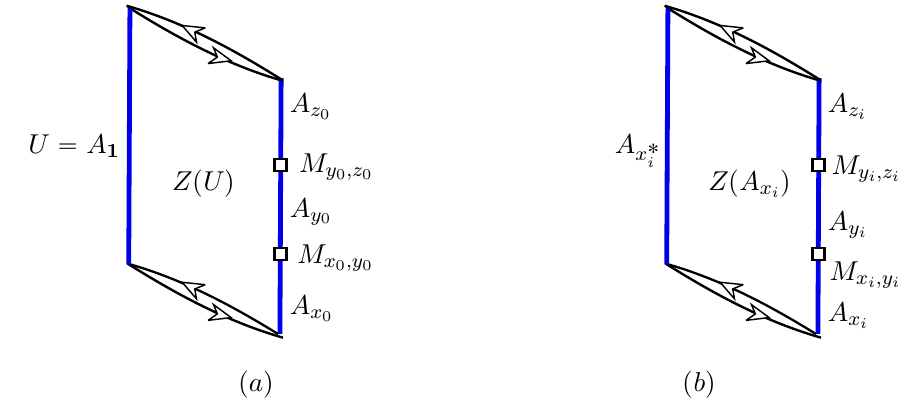
Figure 10 . These two pictures depicts two possible 1+1D world sheets obtained by applying dimensional reduction to (cid:12)gure 5 (a). The associated two sets of boundary CFT’s t A 1 ; A x and t A x ; A y ; A z u are potentially incompatible and M x i i i